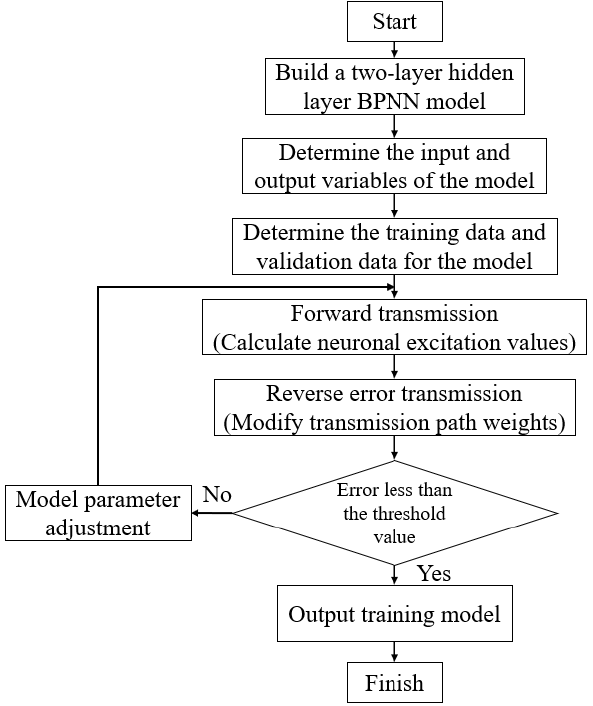
Figure 2. Modeling process based on the BPNN.